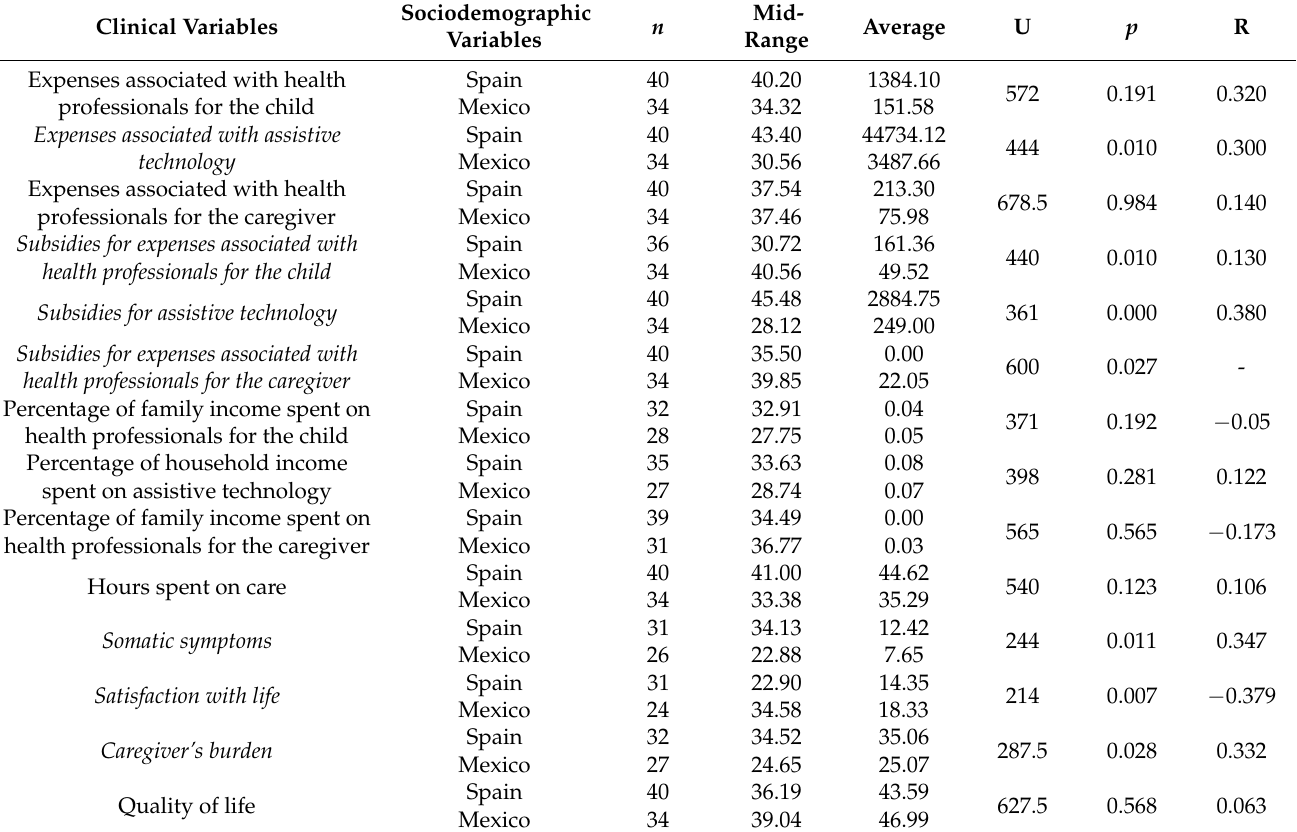
Table 3. Mann–Whitney U-test analysis of clinical variables and nationality ( n =